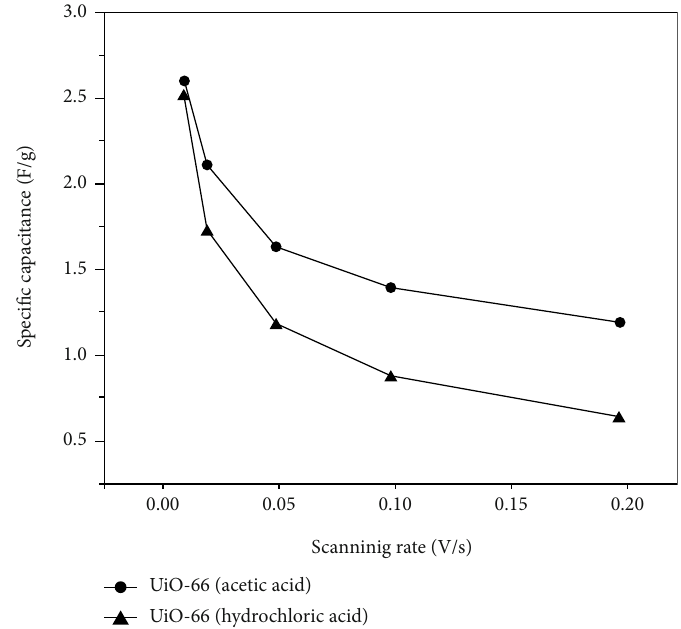
Figure 3: Speci fi c capacitance changes of the two synthesized UiO-66 electrode materials, at di ff erent scanning rates (local magni fi